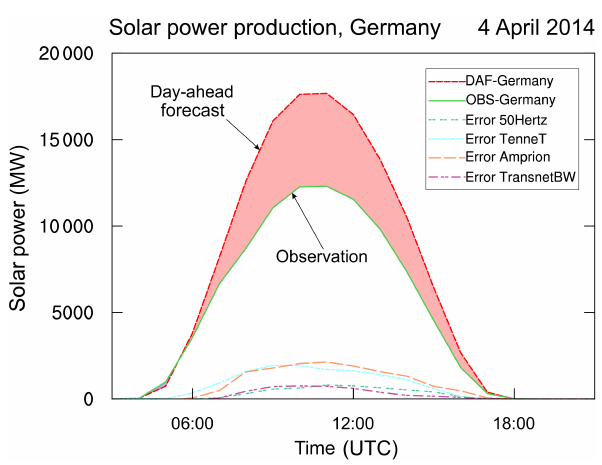
Figure 10. Time series of hourly averaged observed photovoltaic power production (green) and corresponding day-ahead forecast (red) for Germany on 4 April 2014. The red shading marks a large overestimation of up to 5.3GW. At the bottom, the day-ahead fore- cast error for the four German control areas is depicted. Data source: European Energy Exchange AG